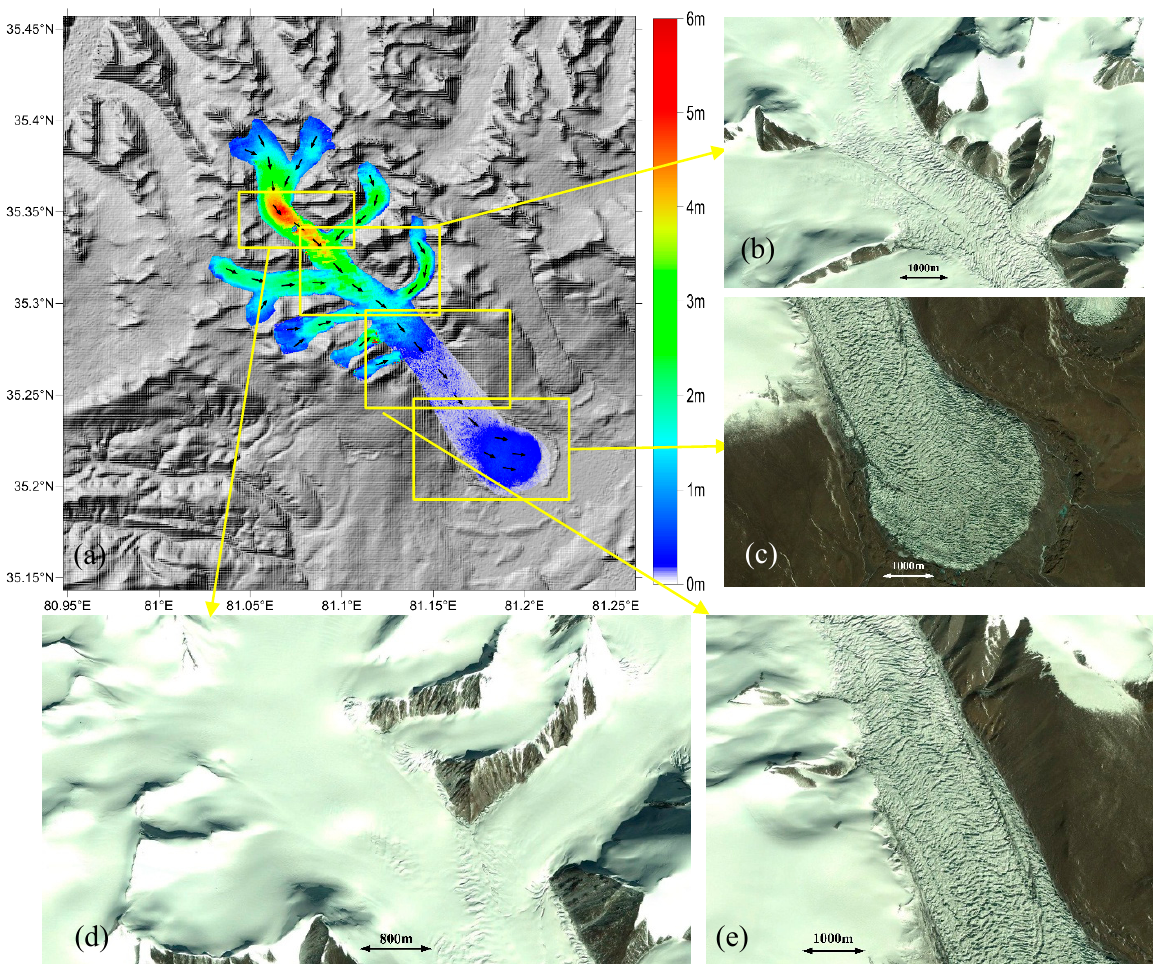
Figure 7. The Chongce Glacier flow field generated by the integrated method. ( a ) The ice motion pattern superimposed on the DEM data; and ( b – e ) optical images from WorldView-2 mosaic image corresponding to different parts of the Chongce Glacier surface.